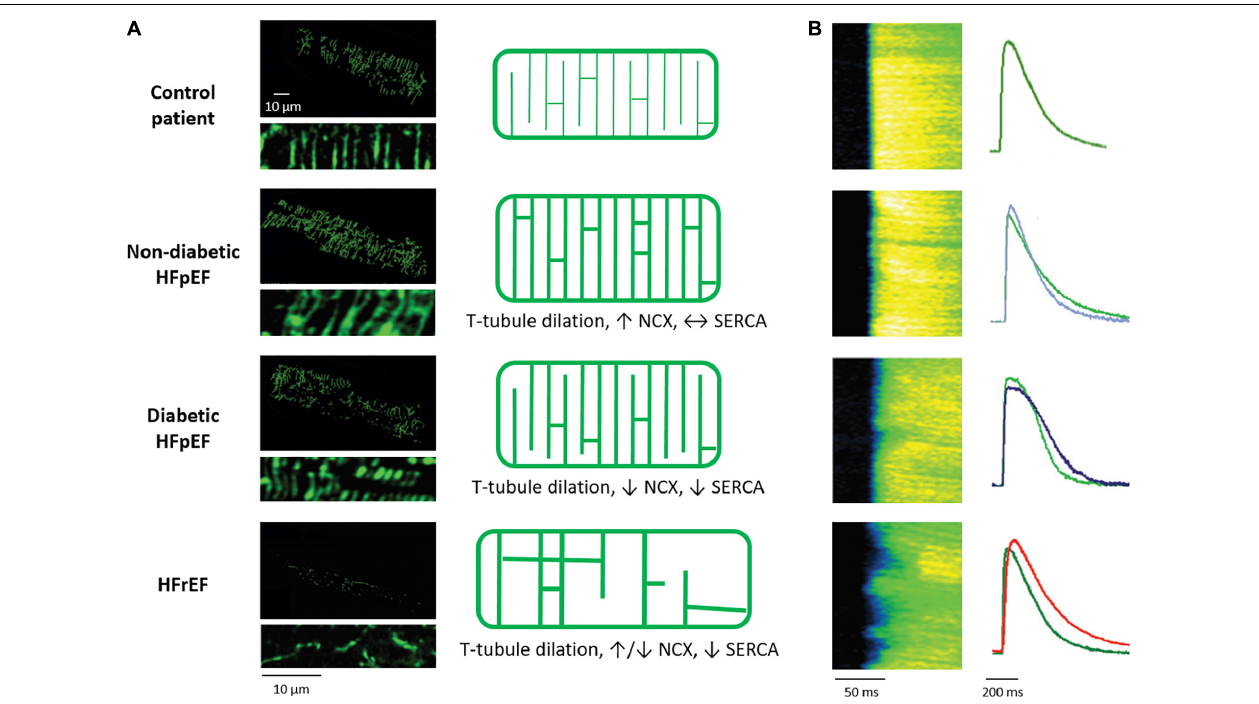
FIGURE 3 | Alterations in cardiomyocyte t-tubule structure and Ca 2 + release in different HF entities. (A) Left panels: 3D reconstructions and 2D zoom-ins of t-tubules imaged in human cardiac biopsies (wheat germ agglutinin staining). Healthy individuals are compared with HFpEF patients, with and without diabetes mellitus, and HFrEF patients. As illustrated in the schematics (right panels), t-tubule density is unchanged in diabetic HFpEF, increased in non-diabetic HFpEF, and decreased in HFrEF. In all HF entities, t-tubules dilate. However, whereas t-tubule remodeling is accompanied by increased NCX and SERCA function in non-diabetic HFpEF, Ca 2 + removal by these proteins is decreased in diabetic HFpEF and HFrEF. (B) T-tubule disruption promotes dyssynchronous and slowed Ca 2 + release in rats with HFrEF but not HFpEF, while slowed Ca 2 + removal promotes diastolic dysfunction in diabetic HFpEF and HFrEF. For each disease state, representative Ca 2 + transients (right panels) are presented with comparison to a control cardiomyocyte (green) for the individual rat models. Micrographs and Ca 2 + transients are reproduced from Frisk et al. (2021) with